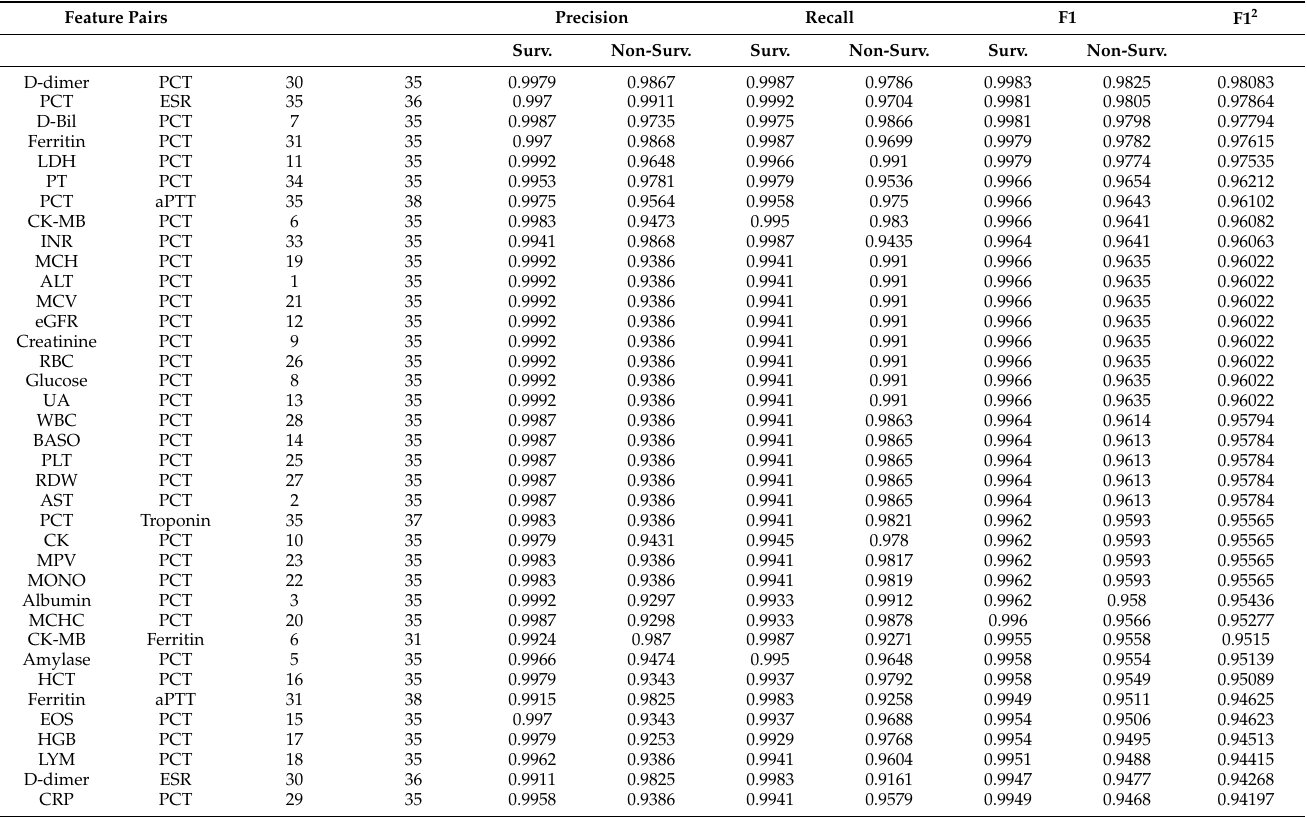
Table 6. Feature pairs with the highest metrics found with the HGB classifier for detection of surviving and non-surviving COVID-19